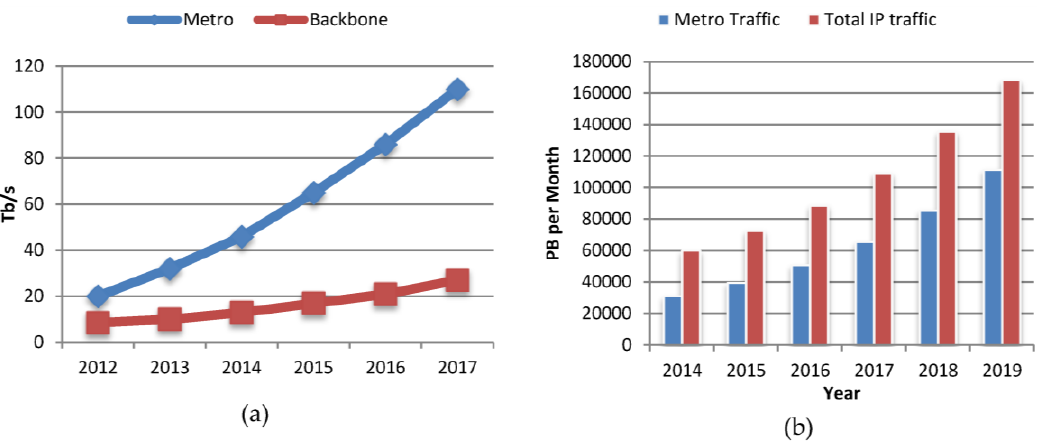
Figure 3. ( a ) Traffic growth in metro and backbone networks. ( b ) Metro and IP traffic growth.